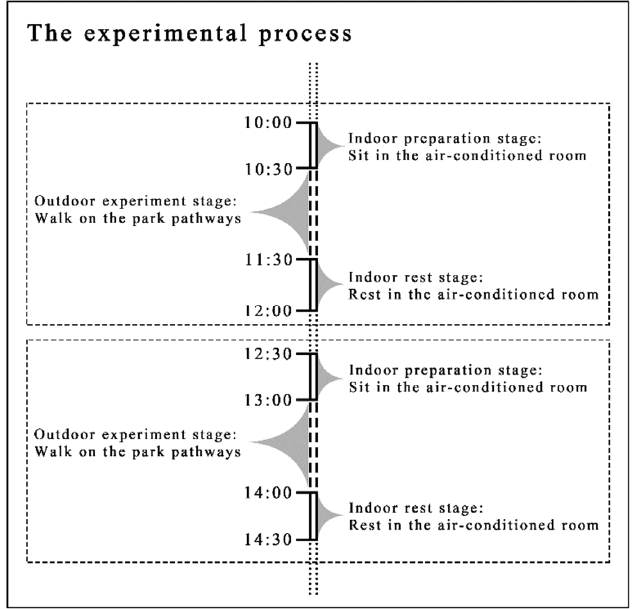
Figure 6. The experimental process chart.